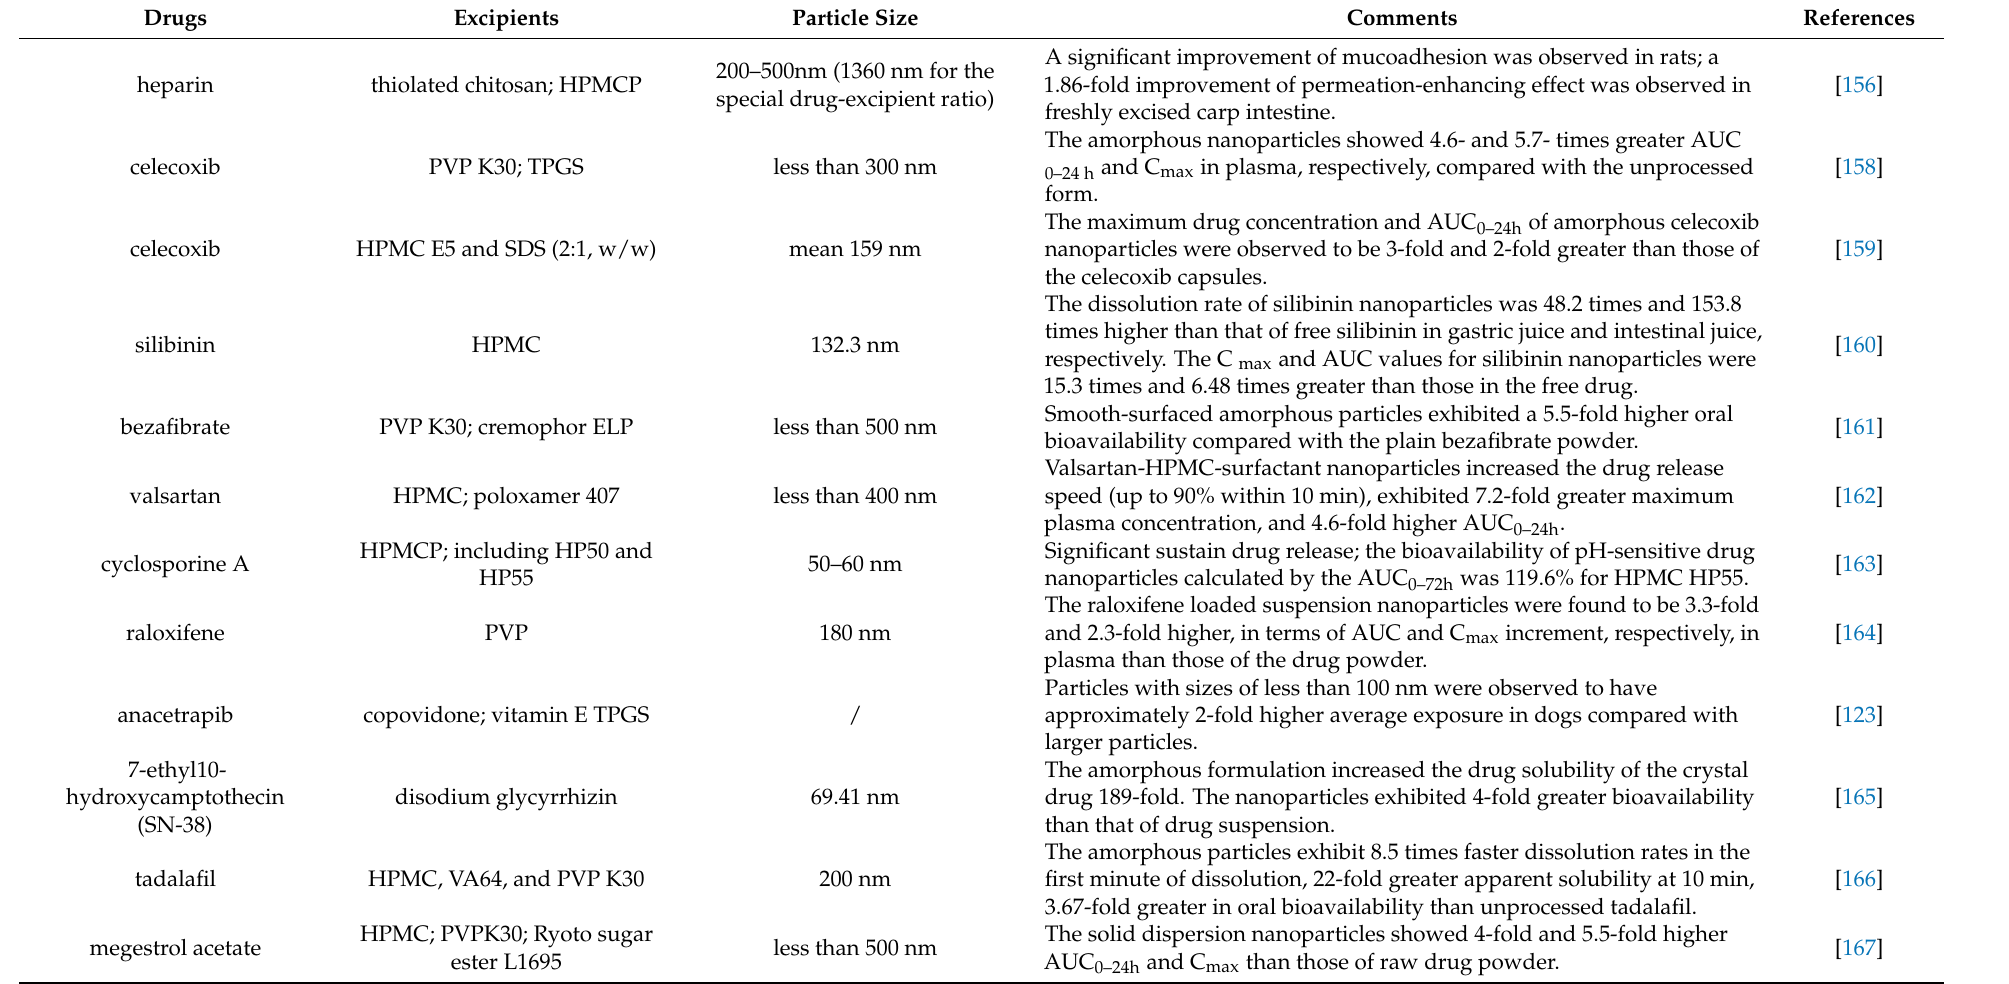
Table 3. Examples of amorphous drug-polymer nanoparticle formulations reported to enhance in vivo drug absorption (from